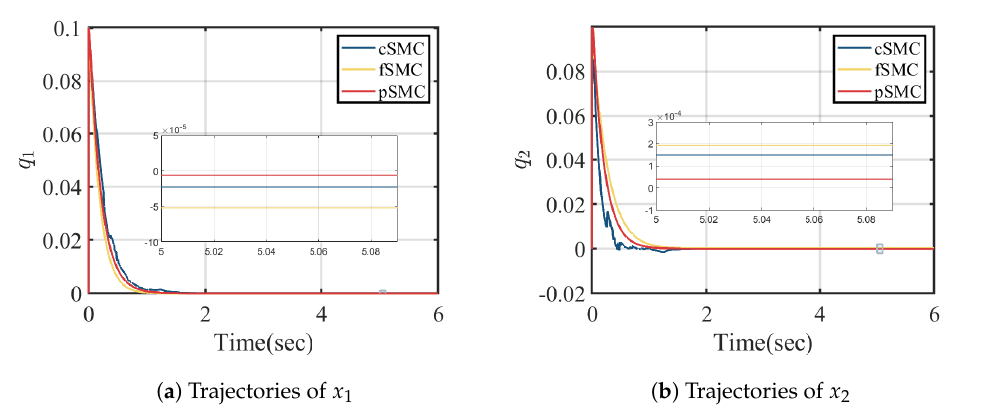
Figure 16. The trajectories of state variables q 1 and q 2 with a far initial state when ρ b = 0.6: cSMC (Blue solid line), fSMC (Yellow solid line) and pSMC (Red solid